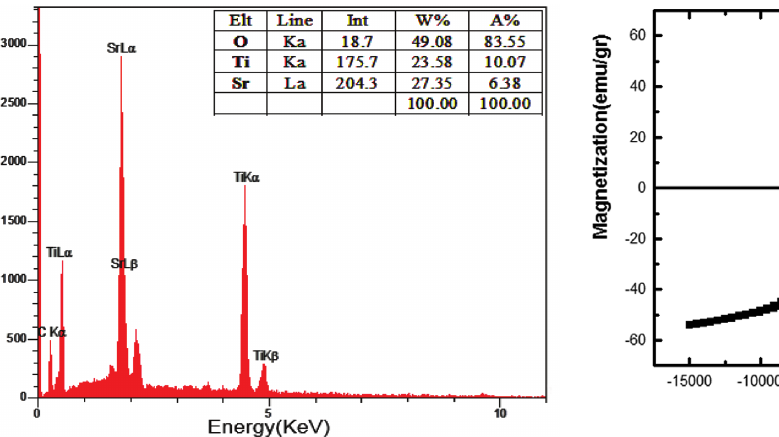
O calcinated at 12 19